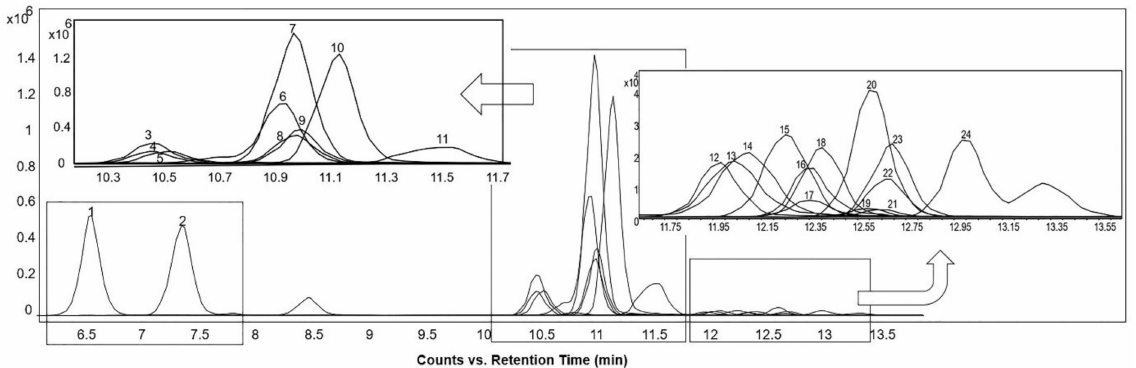
Figure 2. Extracted ion chromatograms of the base peak spectra of detected sterols acquired from reference “BACSMLS” standards in the positive ionization mode. Peak identities are as fol- lows: (1) cortisone, (2) corticosterone, (3) 25-hydroxycholesterol, (4) 24-hydroxycholesterol, (5) 27- hydroxycholesterol, (6) diosgenin, (7) 7 α -hydroxy-4-cholesten-3-one, (8) 7 α -hydroxycholesterol, (9) 7 β -hydroxycholesterol, (10) 7-ketocholesterol (5-cholesten-3 β -ol-7-one), (11) cholesterol 5 α ,6 α - epoxide, (12) desmosterol, (13) ergosterol, (14) 7-dehydrocholesterol, (15) brassicasterol, (16) 5 β - cholestan-3 α -ol (epicoprostanol), (17) lathosterol, (18) cholesterol, (19) coprostanol (coprostan-3-ol), (20) lanosterol, (21) dihydrocholesterol (5 α -cholestan-3 β -ol), (22) stigmasterol, (23) campesterol, (24) β